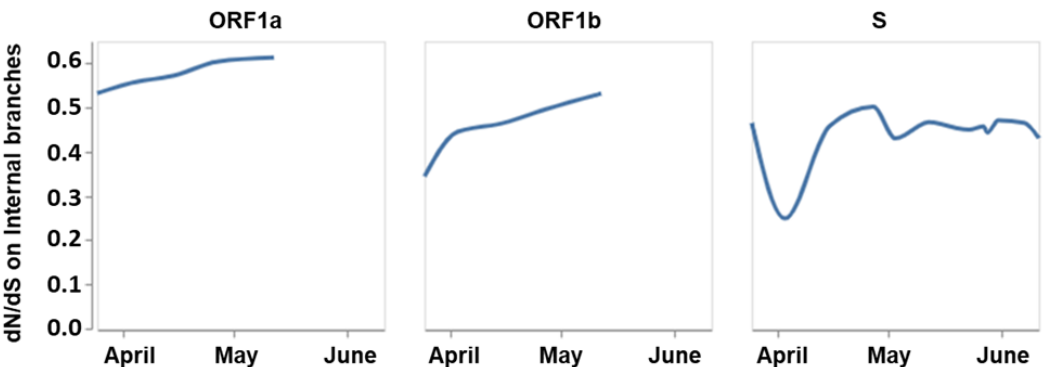
Figure 1. The ratio of SARS-CoV-2 nonsynonymous to synonymous mutations obtained from the Observable notebook (sequencing data available up to June 12, 2020).